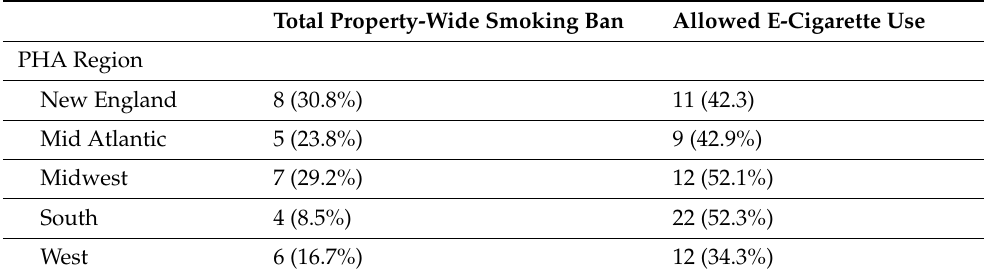
Table 3. Policy variations on outdoor smoking and e-cigarette use among PHAs, by region, size, and year of